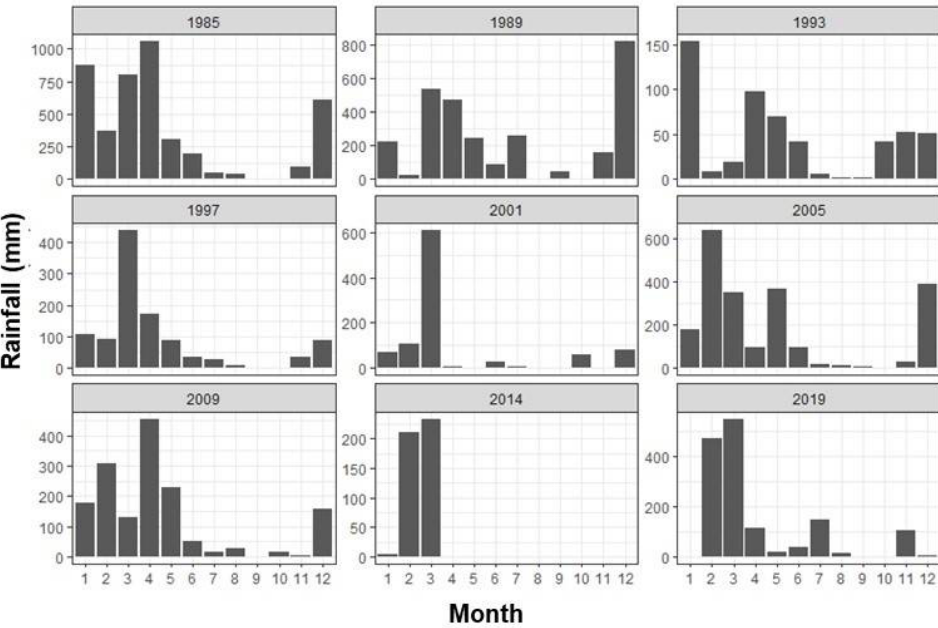
Figure 4. Monthly rainfall in the study area according to image acquisition dates, Floresta-PE.